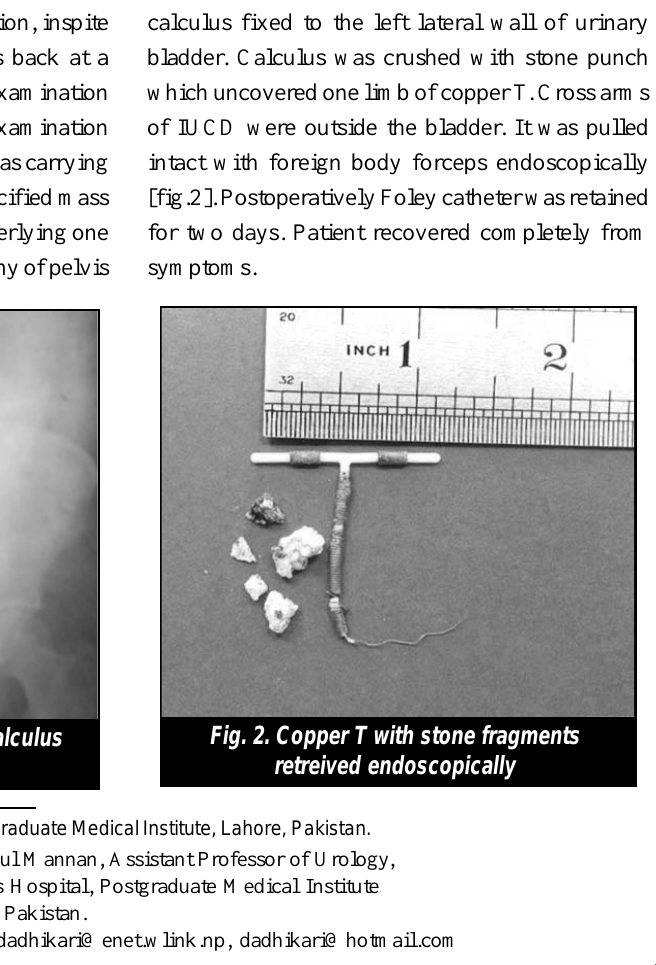
Fig. 2. Copper T with stone fragments retreived